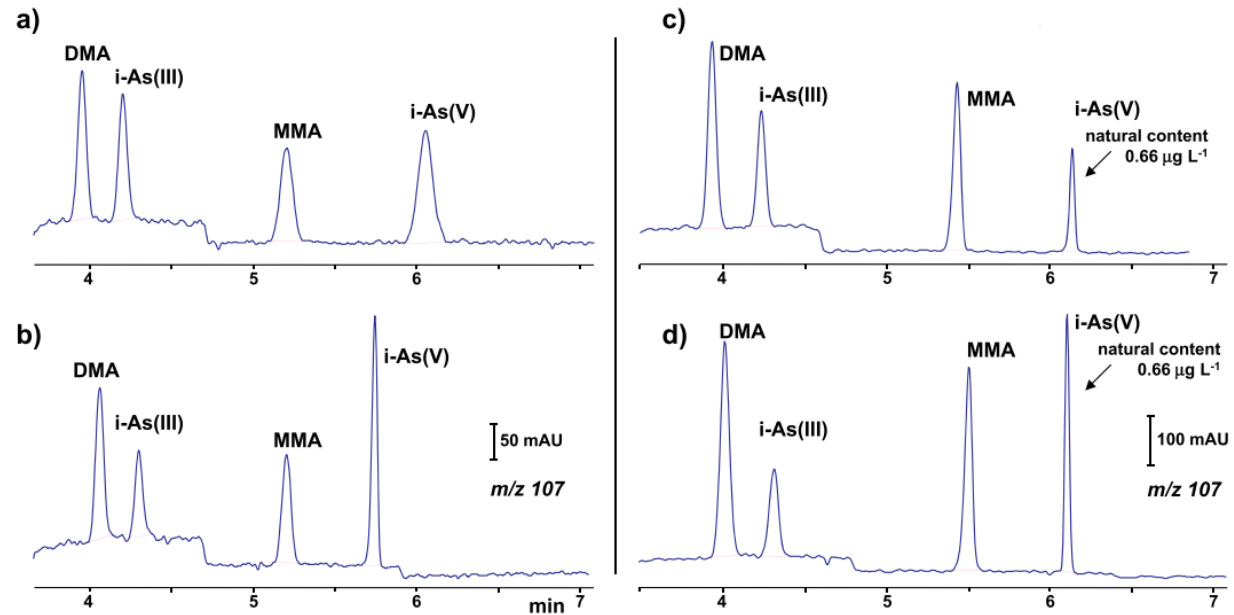
Figure 1. Ion electropherograms recorded in a CE-MS system for the determination of organic and inorganic arsenic compounds [70]: ( a , b ) 25 µ g · L − 1 standard solution ( c , d ) water sample with a natural content of 0.66 µ g · L − 1 i-As(V) and spiked with 1.0 µ g · L − 1 of DMA (dimethylarsinate), i-As(III) and MMA (mono-methylarsonate); ( b , d ) 10% ( v / v ) of a 11% ( v / v ) formic acid solution added to sample before injection. CE conditions: capillary—72 cm, 50 µ m I.D., BGE—57 mM HFIP (hexafluoro-2-propanol) at pH 10.3, hydrodynamic injection—36 s at 50 mbar, V: +30 kV. (Reproduced under permission from Elsevier. License Number 5173120352687).